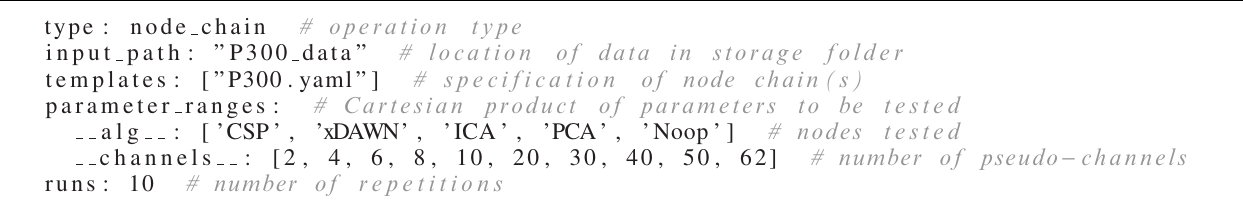
FIGURE 5 | Operation specification example file for spatial filter comparison. For more details see discussion in section 5.1.